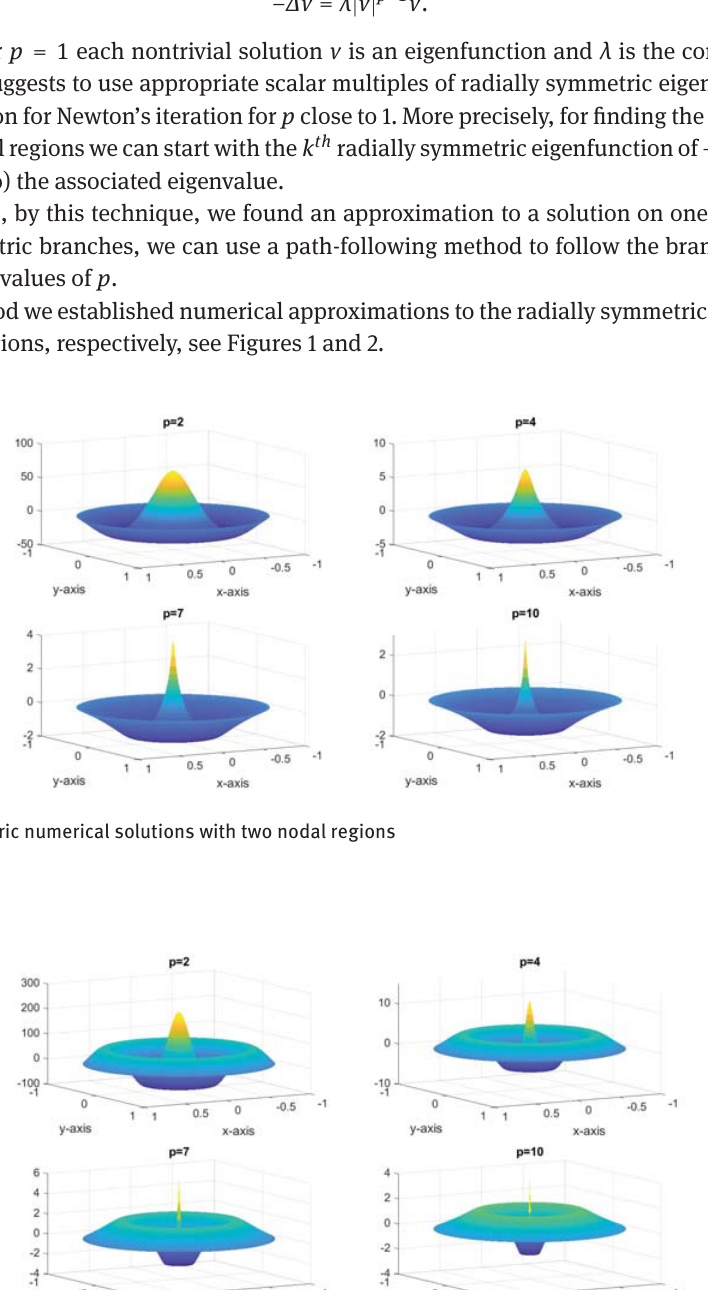
2. Non-radial solutions: we look for non-symmetric solution branches bifurcating from a radially